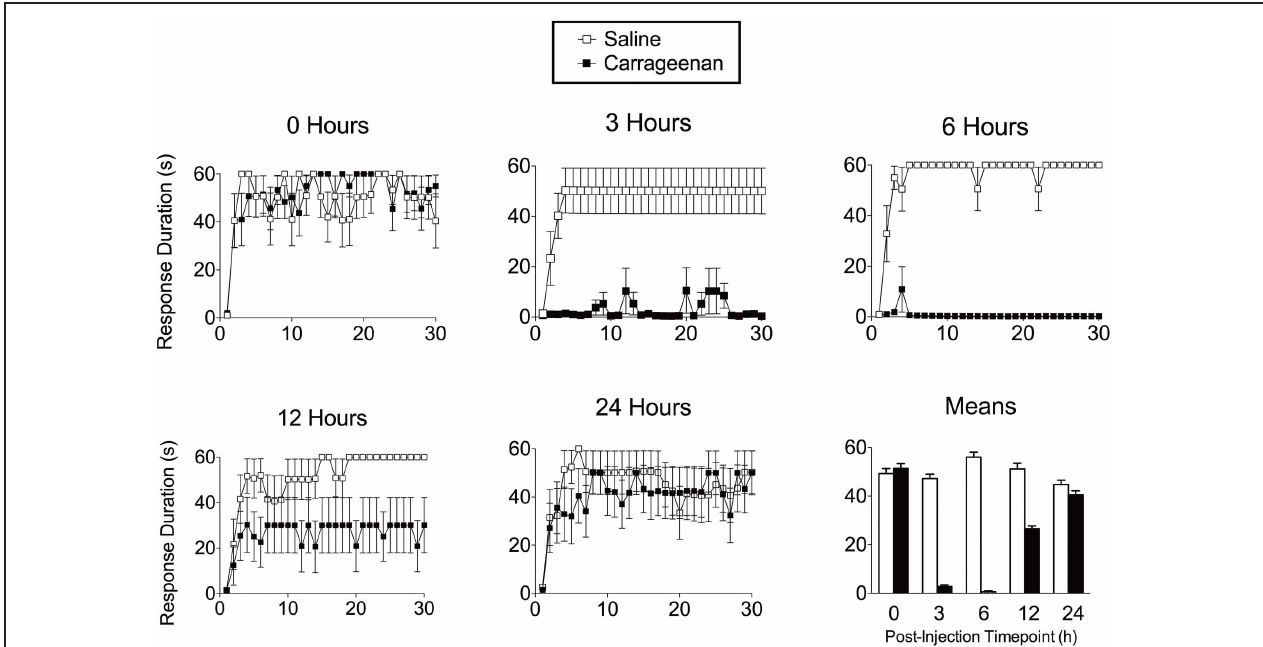
FIGURE 3 | Peripheral inflammation with intradermal carrageenan produces transient impairment in spinal cord learning on the contralateral leg. The timecourse of these learning deficits mimic the known timecourse for carrageenan-induced central sensitization. Adapted from Ferguson et al. (2006).